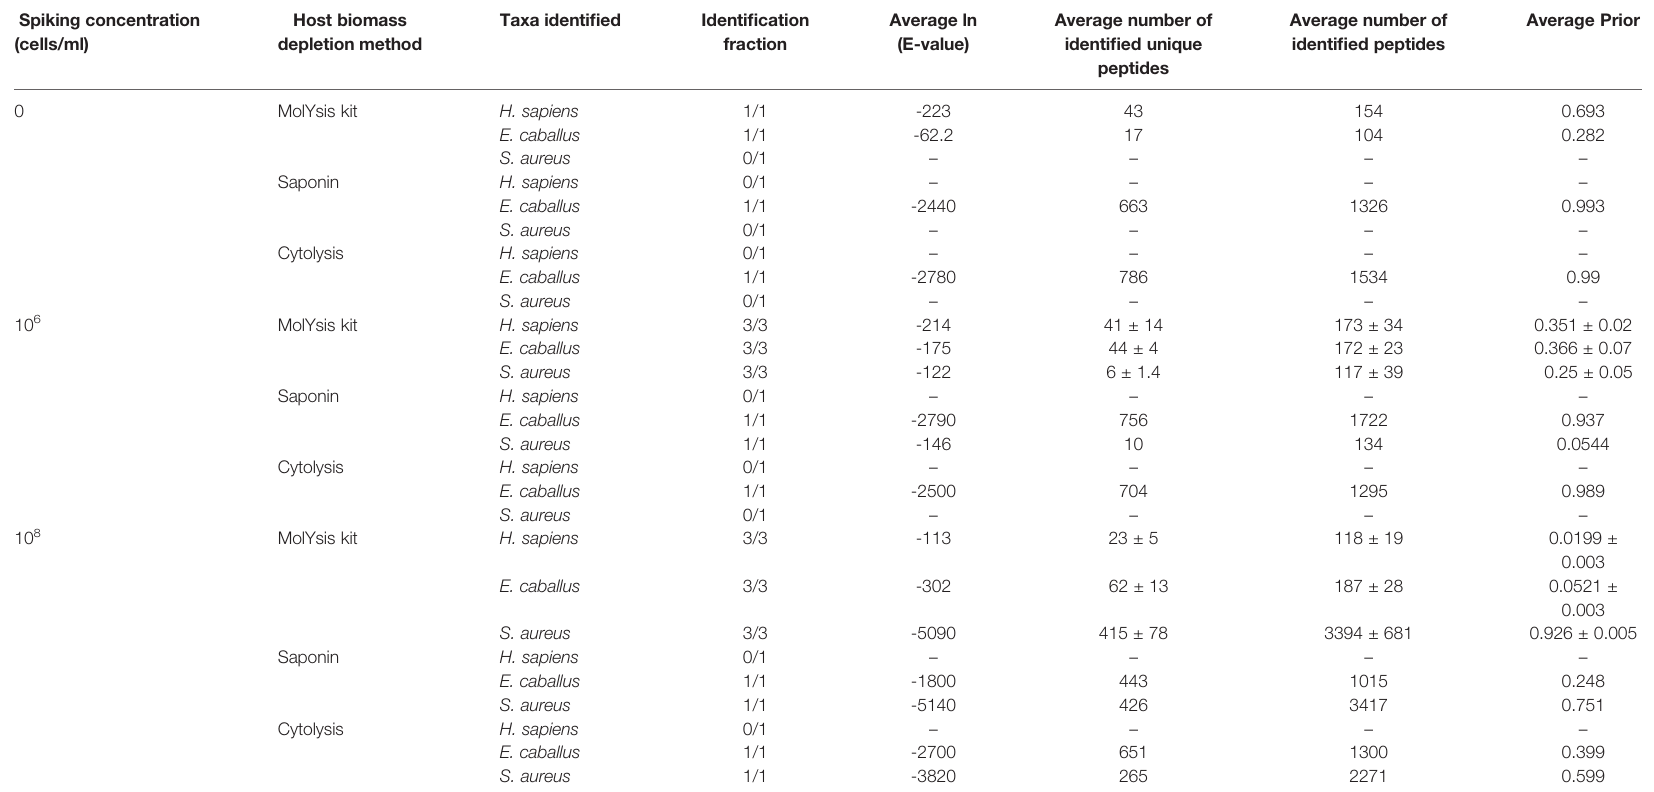
TABLE 1 | Assessment of host biomass depletion methods prior to MS analyses. Spiking concentration